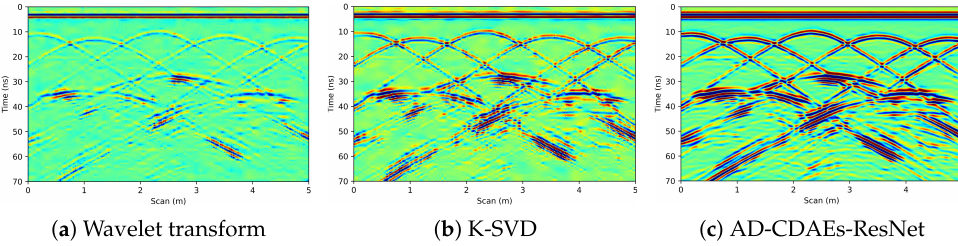
Figure 12. Noise attenuation result for the GPR profile of the tunnel lining compared with other